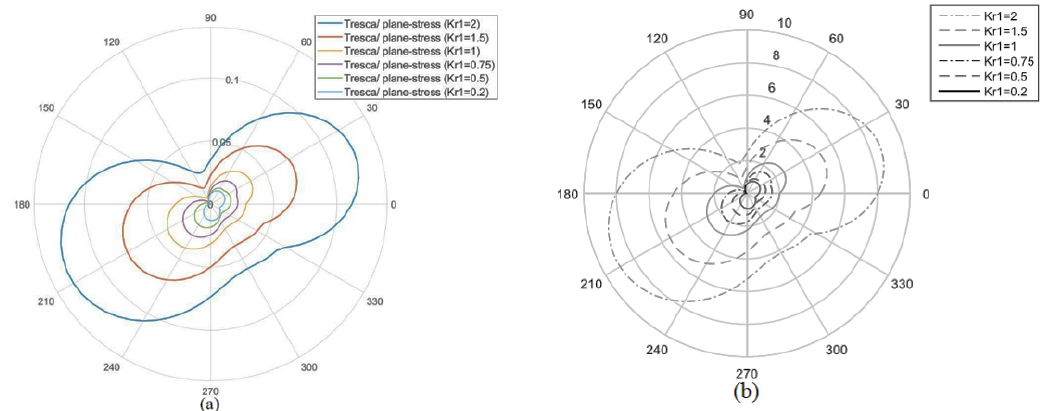
Figure 5. The shapes of the plastic zone around a sharp crack based on the Tresca yield criterion; ( a ) obtained from the present study and ( b ) reported in [63].